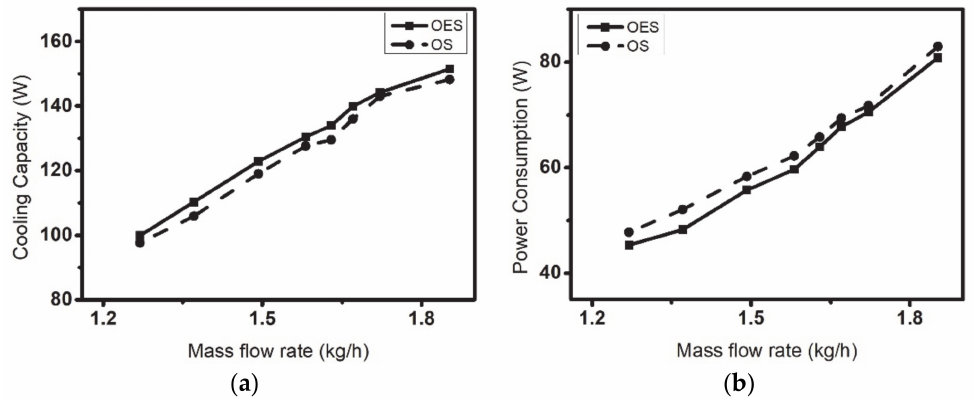
Figure 6. ( a ) Cooling capacity variation with mass flow rate; ( b ) Input power variation with mass flow rate when ambient temperature is 25 ◦ C and humidity is 50% conditions.